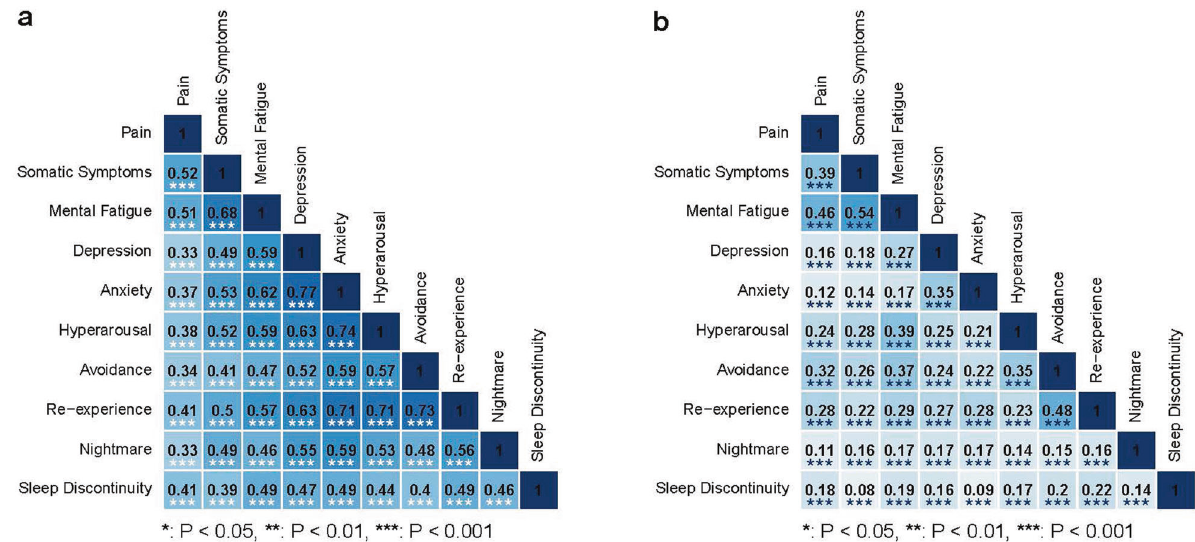
Fig. 2 Correlations among common post-traumatic symptoms during the eight weeks after motor vehicle collision (MVC). Correlations among intercepts a and slopes b of the trajectories of common post-traumatic symptoms during the eight weeks after motor vehicle collision (MVC) are displayed; darker shading indicates a higher correlation. Trajectory intercepts from latent growth curve models represent peritraumatic symptom levels in the initial days after MVC. Slopes represent changes in symptoms during the fi rst 8 weeks after